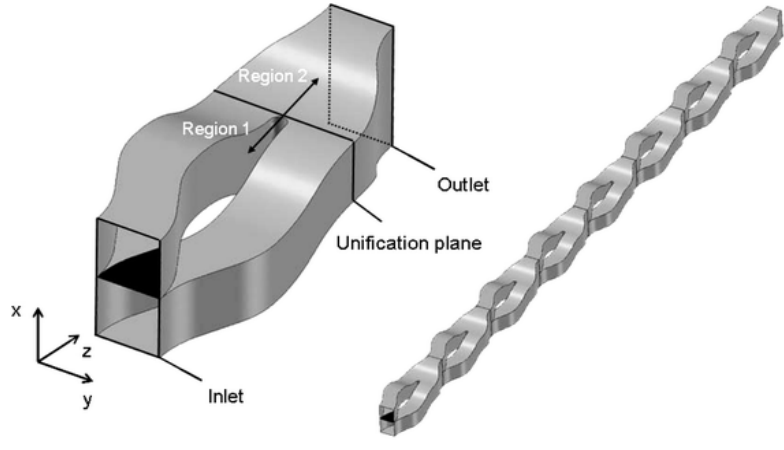
Figure 18. Enlarged view of the SAR unit (left) composing the 8-unit mixer (from Hardt et al.